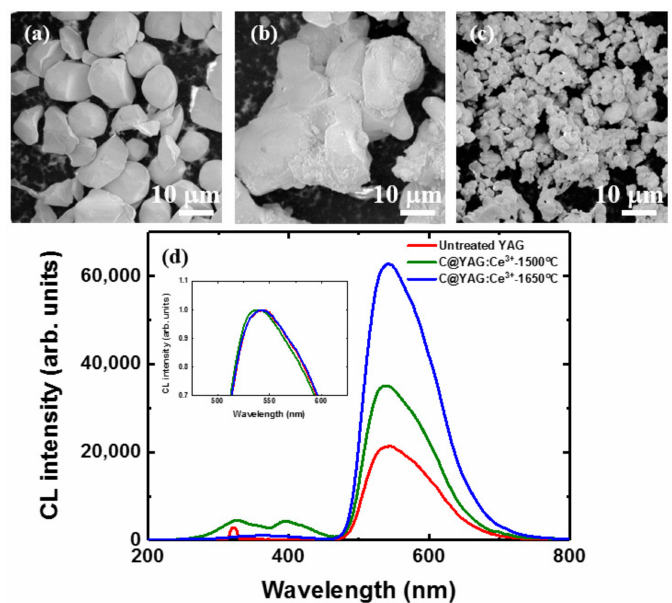
Figure 4. SEM images for untreated YAG:Ce 3+ ( a ); C@YAG:Ce 3+ -1500 ◦ C ( b ); C@YAG:Ce 3+ -1650 ◦ C ( c ) and ( d ) CL spectra for untreated YAG:Ce 3+ , C@YAG:Ce 3+ -1500 ◦ C, and C@YAG:Ce 3+ -1650 ◦ C, with inset of CL spectra normalized by their respective